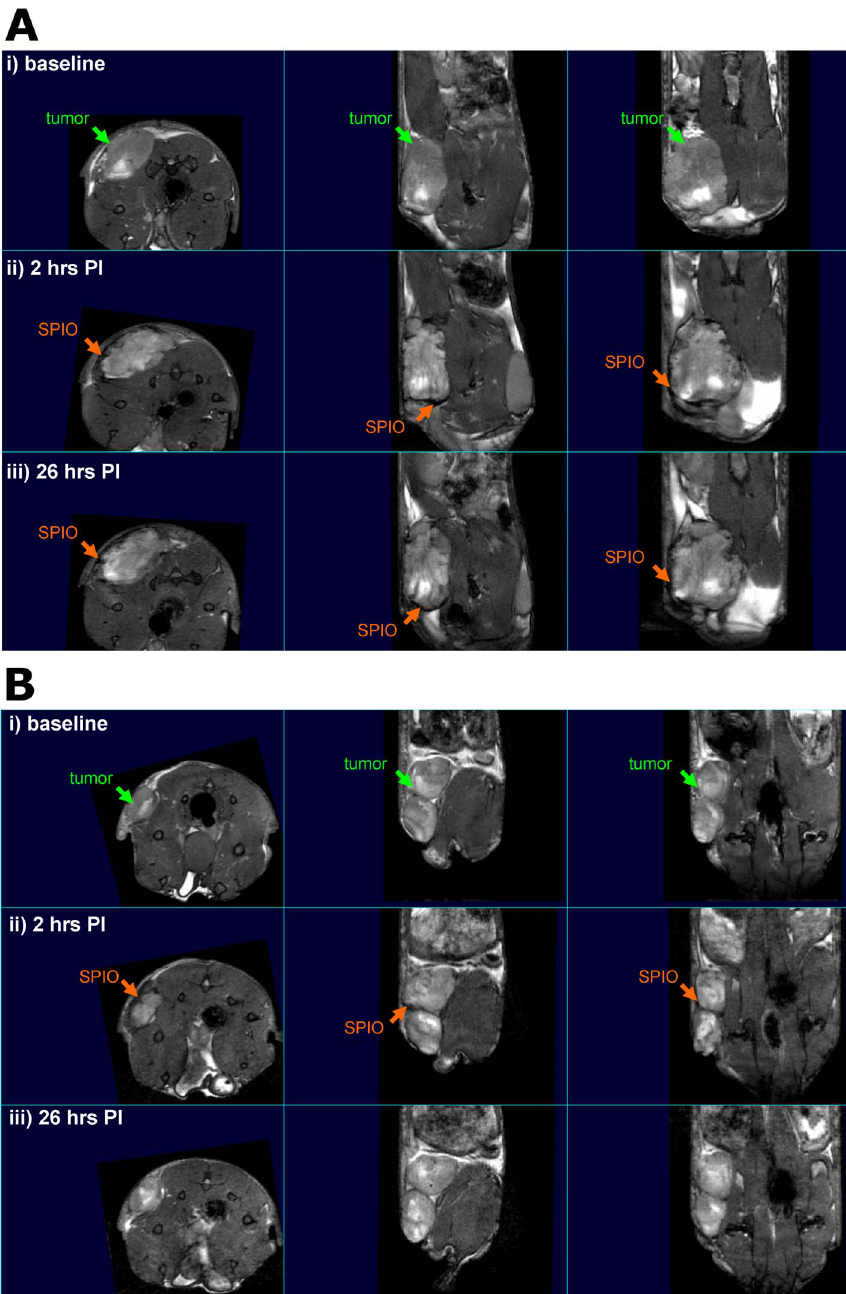
Figure 5. 150 m m 3 axial, saggital and transverse MRI images. A mouse injected with SOR-C27-SPIO at each MRI time point showing i baseline tumor site, ii the accumulation of SPIO at 2 hours post-injection and iii SPIO persistence at tumor site at 26 hours post-injection ( A ). A mouse injected with SPIO control bead at each MRI time point showing i baseline tumor site, ii the initial accumulation of SPIO at 2 hours post-injection and iii SPIO clearance at tumor site at 26 hours post-injection ( B ). which could be advantageous for therapeutics and diagnostics. In addition, the route of metabolism and excretion of fluorescently tagged SOR-C27 involves the liver and kidney with greatly reduced processing in lymph nodes and at the tumor site. Unbound SOR peptides appear to be rapidly degraded and excreted, potentially minimizing the risk of off-target effects.